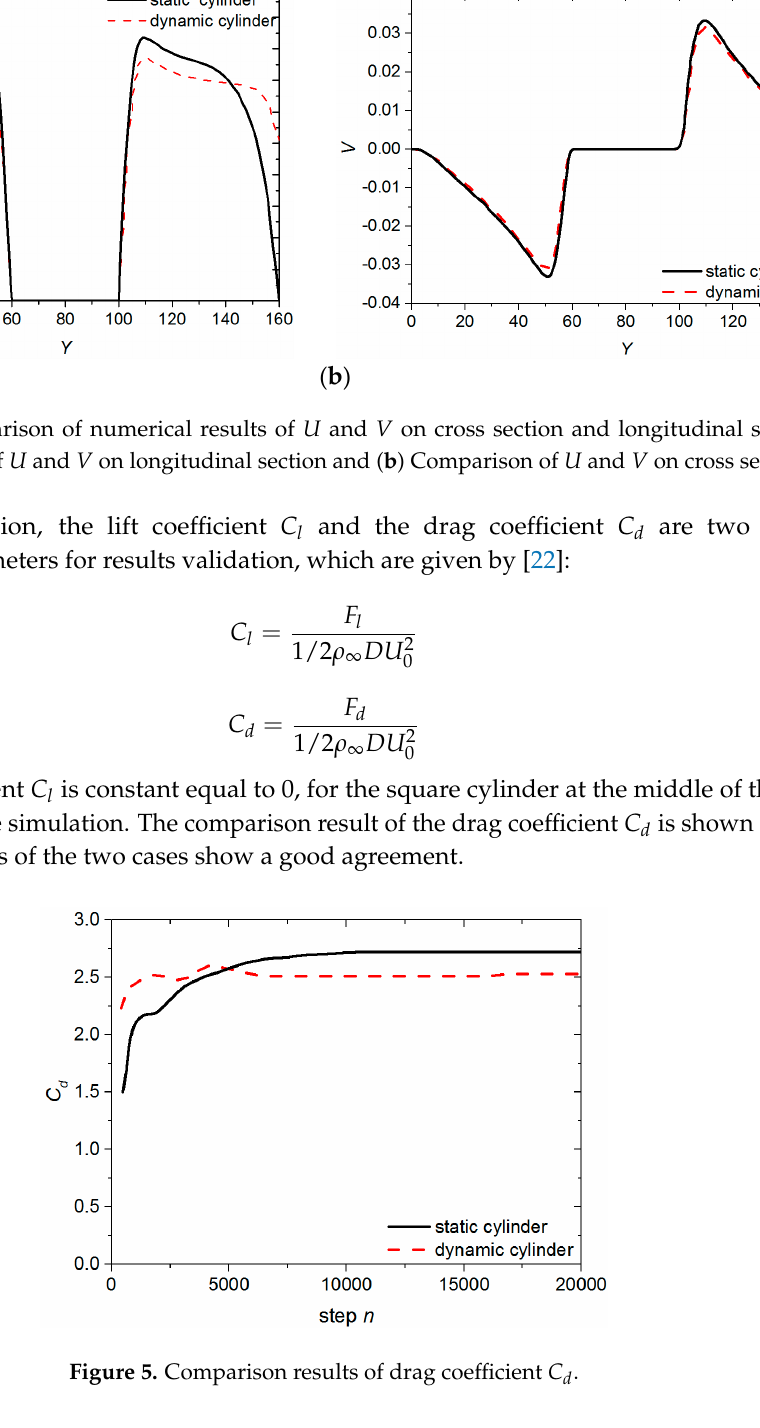
Figure 5. Comparison results of drag coefficient